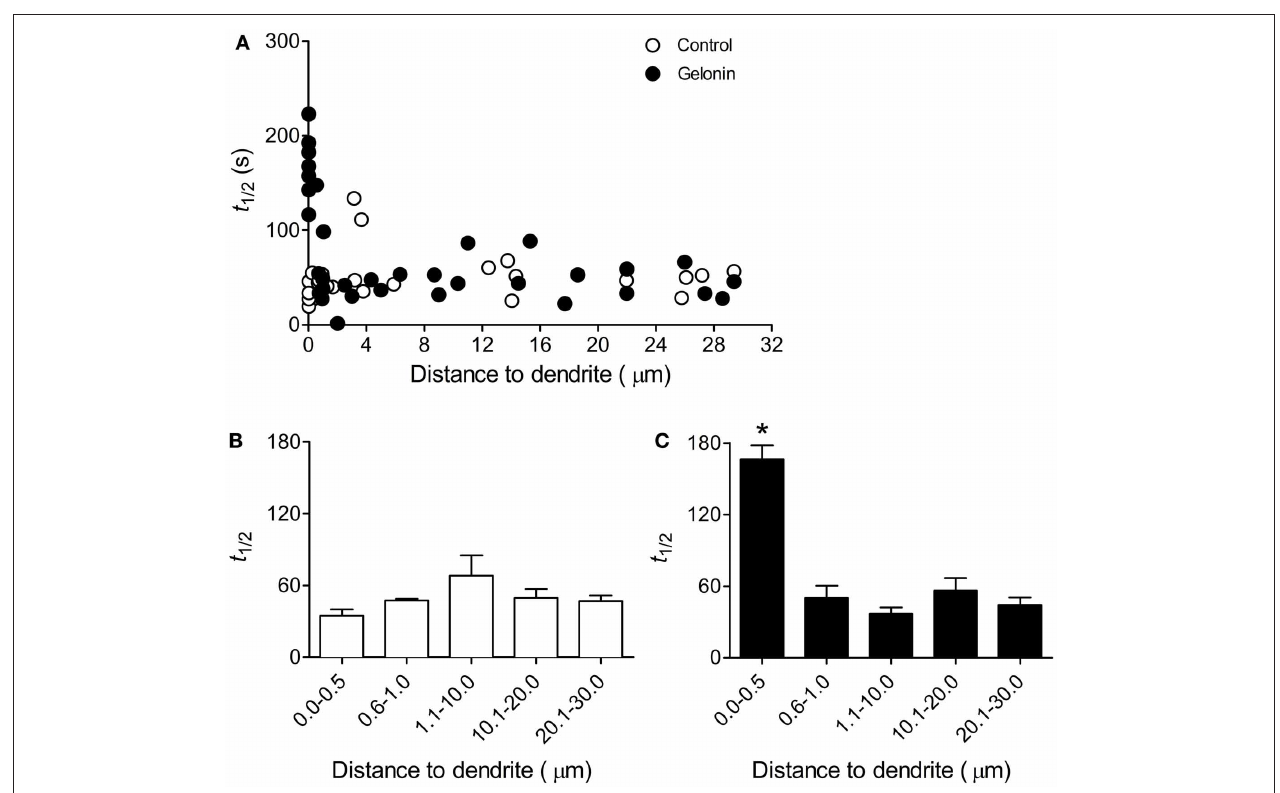
FIGURE 4 | Enhanced presynaptic function associated with LTP3 is dependent on postsynaptic translation. (A) Scatter plot showing the half-life of FM 1-43 destaining versus distance to filled dendrite for individual terminals in slices stimulated with 8TBS with and without gelonin in the patch pipette. (B) Histogram summarizing destaining rate data obtained from the “Control” group in (A) except with